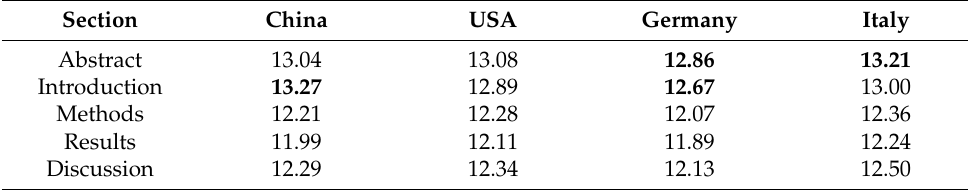
Table 10. Average Dale–Chall scores of article sections from selected countries.